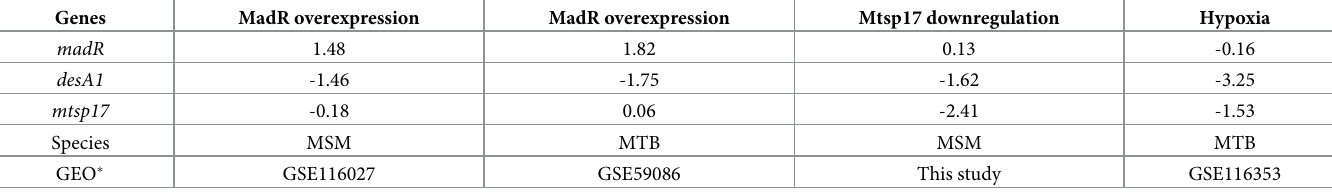
Mtsp17 is involved in regulation of the SigF regulon via an anti-SigF antagonist Transcription in MSM is carried out by a multi-subunit RNA polymerase and one of 28 sigma subunits [15]. The sigma subunit ensures the transcription machinery to initiate transcription of particular genes [16,17]. Sigma factors are post-translationally regulated by a partner switch- ing system (PSS) in which anti-sigma factors sequester the sigma factor from the transcription machinery and anti-sigma factor antagonists lift the repression of sigma factors [18–20]. MSMEG_0586, an anti-SigF antagonist, was one of the top 20 differentially expressed genes, showing an 8.9-fold decrease (log fold change = -3.16, adjusted p-value = 7.3E-40) in 2 the M0129C_T0 versus M0129C_T20 comparison, while other sigma factors or anti-sigma fac- tors or anti-anti-sigma factors showed log fold changes of no more than 1.5. MSMEG_0586 is 2 involved in the PSS of the SigF regulatory pathway [20]. In light of significant down-regulation of the anti-SigF antagonist MSMEG_0586 and no obvious change in other SigF PSS factors in the conditional Mtsp17 knockout strain, we hypothesized that transcriptomic changes partially overlapped between the conditional Mtsp17 knockout and the SigF knockout strains. When DEGs in the M0129C_T0 versus M0129C_T20 comparison were compared with DEGs in the SigF knockout versus wildtype comparison [21], 70 of 79 DEGs with log fold changes > 1.5 2 and adjusted p-values of < 0.05 showed the same fold change trends (S5 Table). Furthermore, Table 3. Log 2 fold change values of genes in different pair-wise comparisons. Genes MadR overexpression MadR overexpression Mtsp17 downregulation Hypoxia madR 1.48 1.82 -0.16 desA1 -1.46 -3.25 mtsp17 -0.18 -1.53 Species MSM MTB MSM MTB GEO � GSE116027 GSE59086 This study